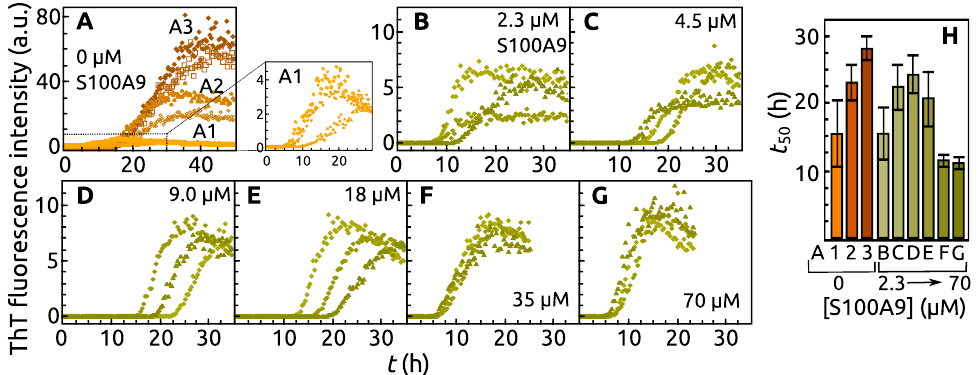
Figure 1. Aggregation kinetic curves of α -syn ( A – G ) and the respective t 50 ( H ) at different concentra- tions of S100A9: 0.0µM ( A ), 2.3µM ( B ), 4.5µM ( C ), 9.0µM ( D ), 18µM ( E ), 35µM ( F ), and 70µM ( G ). A1, A2 and A3 denote different populations of α -syn kinetic curves. Protein solution: 70µM α -syn, PBS buffer, 0.02% NaN 3 , 50µM ThT, pH7.4. Aggregation performed at 37°C with constant agitation of 300RPM. The error bars are the standard deviation from the mean (12